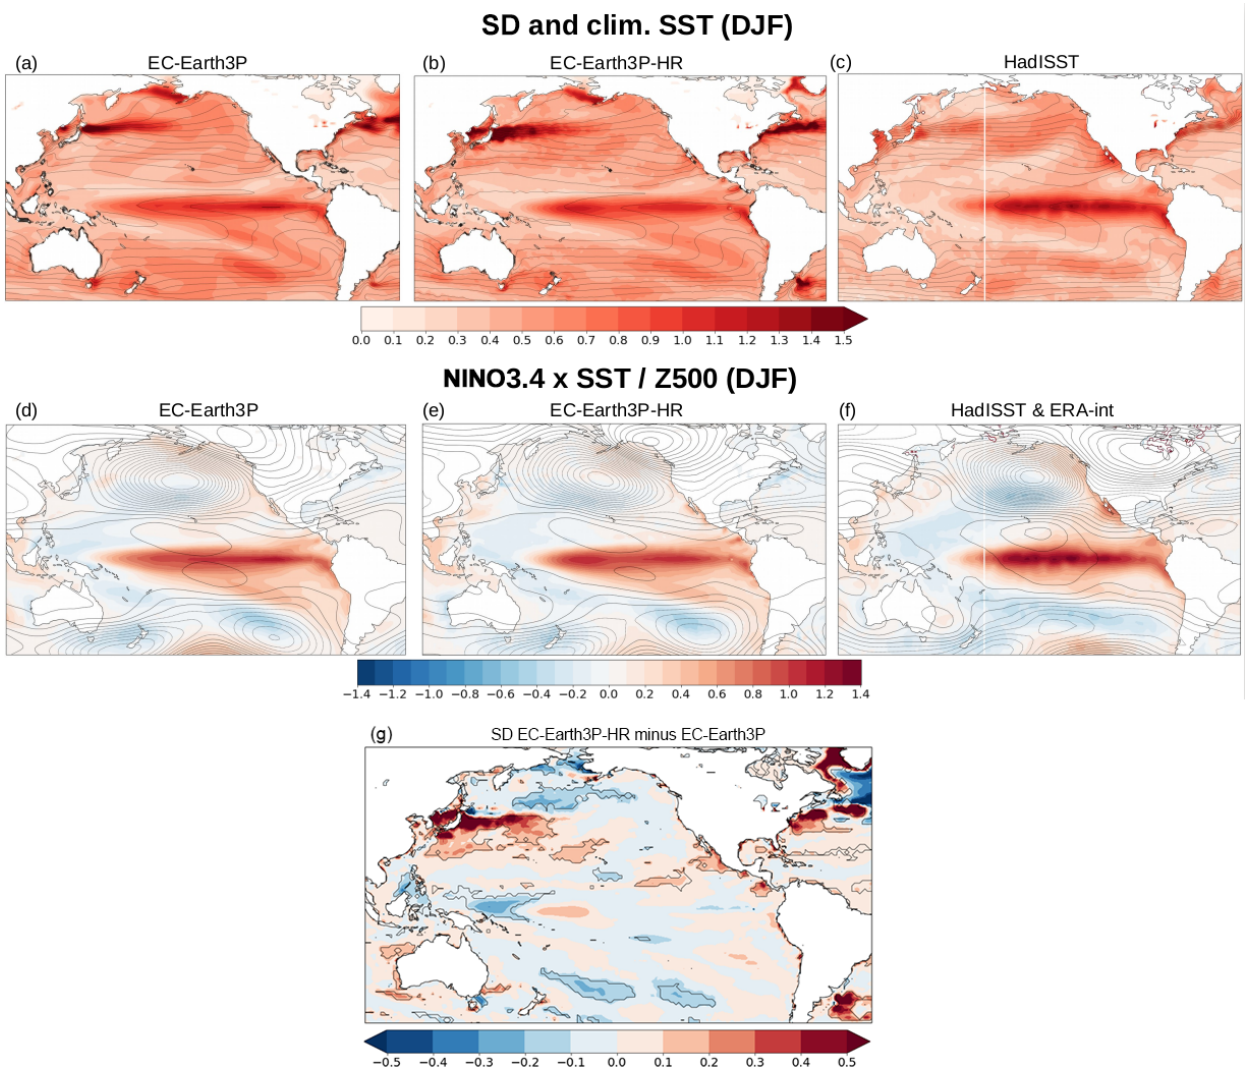
Figure 14. (a–c) Boreal winter SST standard deviation from control-1950 in EC-Earth3P (a) , EC-Earth3P-HR (b) and detrended HadISST (c) ; overplotted with contours are the corresponding climatology (contour interval 2 ◦ C). Bottom: regression of SST anomalies onto the NINO3.4 index from control-1950 in EC-Earth3P (d) , EC-Earth3P-HR (e) and detrended HadISST (f) ; overplotted with contours are the corresponding regression of 500hPa geopotential height anomalies (c.i. 2.5m), with ERA-Interim in panel (f) . The observational period is 1979–2014. (g) Difference in SST standard deviation between EC-Earth3P-HR (b) and EC-Earth3P (a)